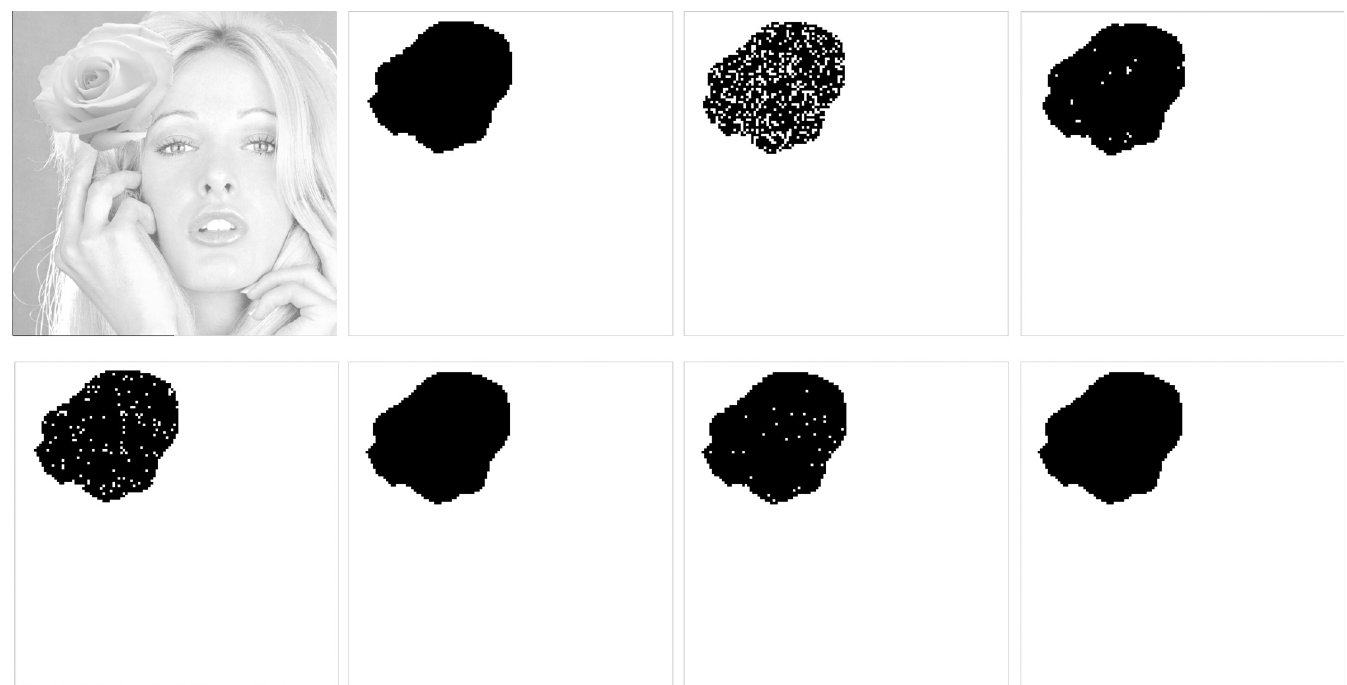
Fig 9. Detectability comparisons of coarse and refined detections for various λ . (a) Tampered image. (b) Tampered area. (c) Coarse detection λ = 4. (d) Refined detection λ = 4. (e) Coarse detection λ = 16. (f) Refined detection λ = 16. (g) Coarse detection λ = 64. (h) Refined detection λ = 64.